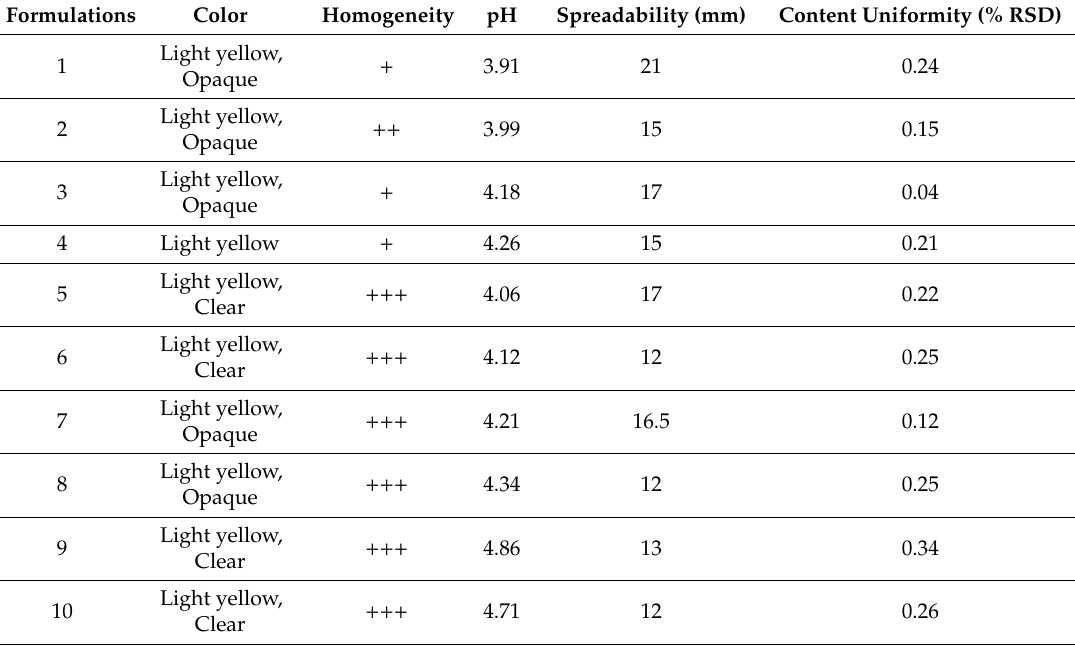
Table 2. Physicochemical properties of TQ topical hydrogel formulations